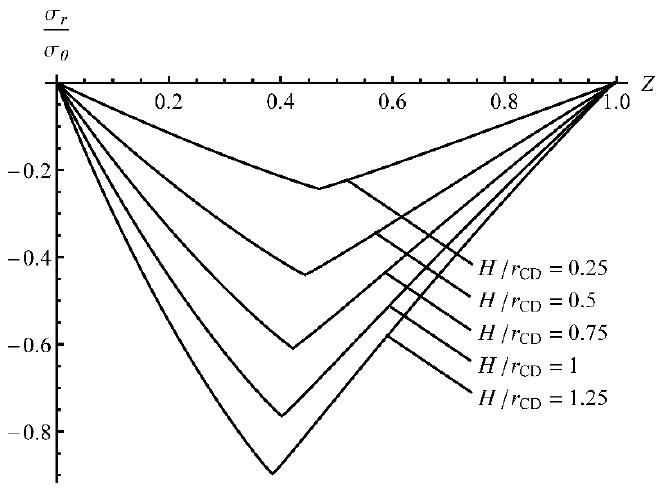
Figure 4. Through ‐ thickness distribution of the radial stress at γ = 1 and several process stages. Figure 4. Through-thickness distribution of the radial stress at γ = 1 and several process